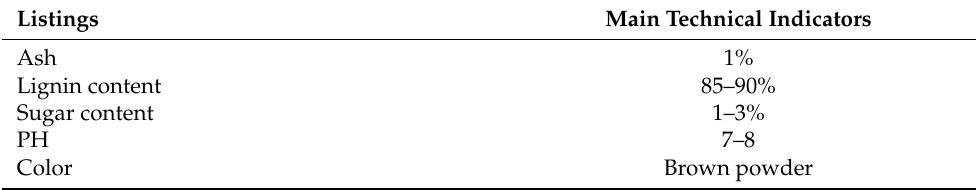
Table 2. Technical specifications for lignin.